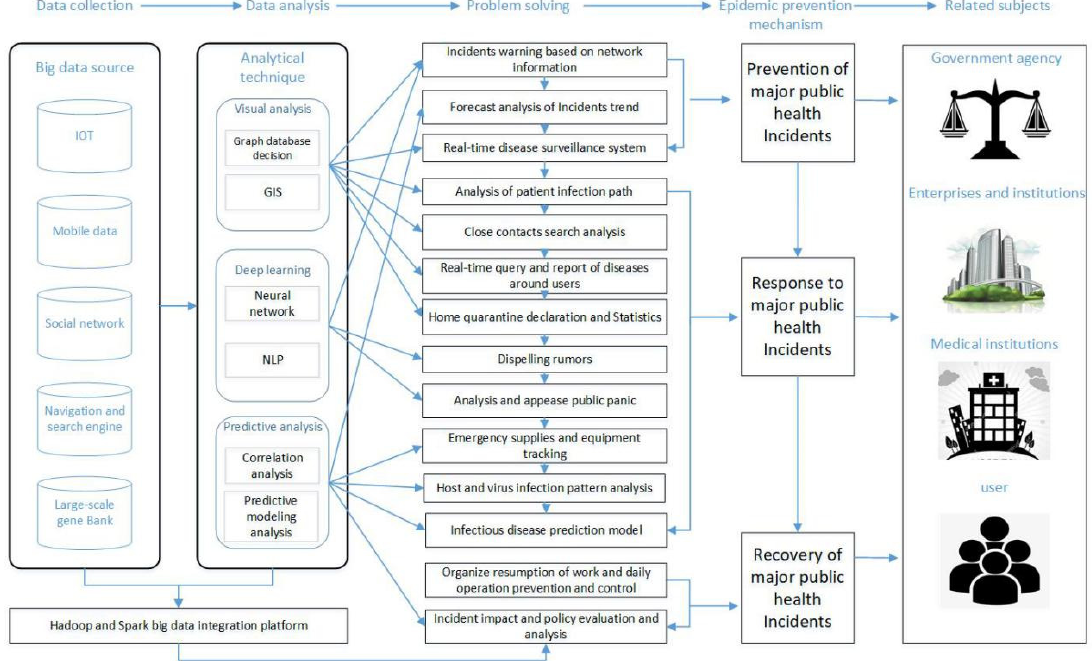
Figure 6. Decision framework for fight against major public health incidents based on big data analytics.